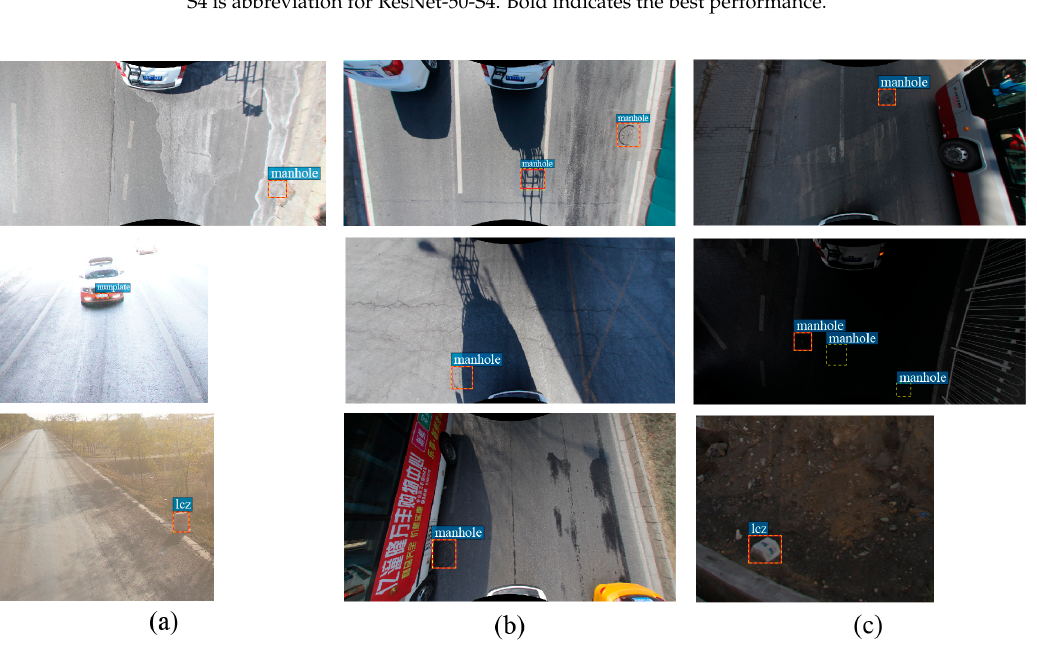
Table 8. Performance of the ADSS module and GIoU loss with the ResNet-50-S4 on the UED dataset. ADSS Method S4